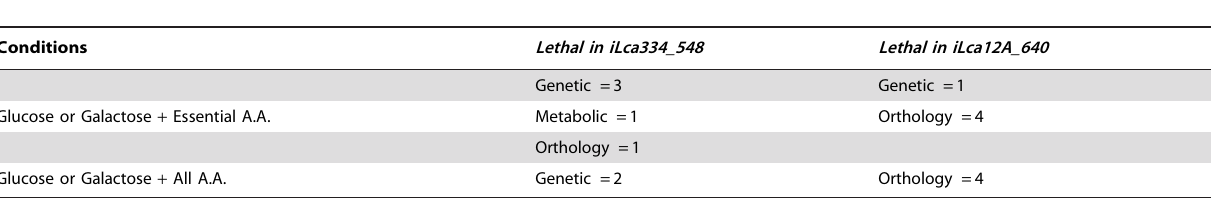
Table 5. Number of gene deletion sets found by CONGA under four different conditions between i Lca334_548 and i Lca12A_640.